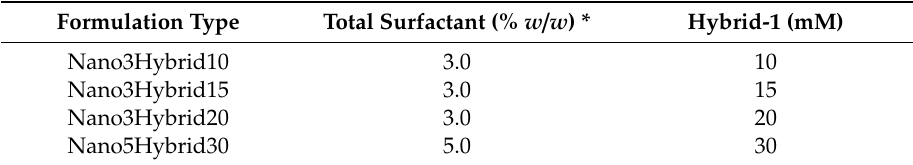
Table 5. Composition of the mixtures used for the preparation of hybrid-loaded